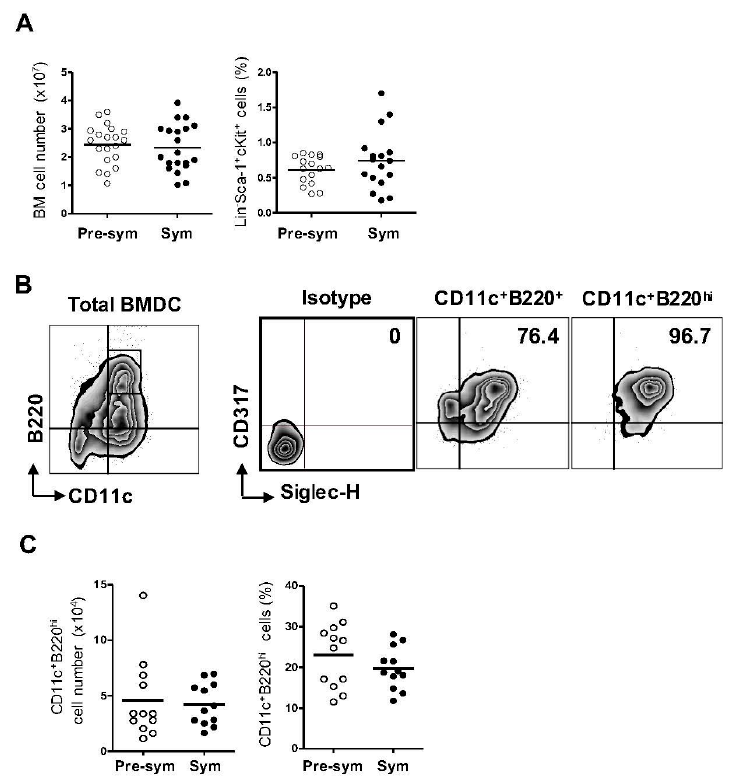
Figure 1. Gross development of pDCs is not affected by lupus. ( A ) Total numbers of bone marrow (BM) cells and frequencies of hematopoietic stem cells, marked by Lineage − (Lin − ) Sca-1 + c-Kit + (LSK), from pre-symptomatic (Pre-sym) and symptomatic (Sym) mice were compared. Collective data from more than 10 independent experiments, totaling n = 16–20 in the respective charts shown. Each symbol represents one mouse; ( B ) Cells generated from Flt3-ligand-supplemented BM culture at day-8 were analyzed. The expression of CD11c and B220 on live-gated cells as well as the expression of CD317 and Siglec-H on CD11c + B220 + - or CD11c + B220 hi -gated cells are shown in representative contour plots. Isotype antibodies control was used for the gating of CD317 and Siglec-H positive cells. Numbers shown are the percent of double positive cells; ( C ) Collective data from at least 3 independent experiments on the total numbers and frequencies of CD11c + B220 hi pDCs in the pre-symptomatic and symptomatic BM cultures are presented. Each symbol represents one mouse ( n = 12).